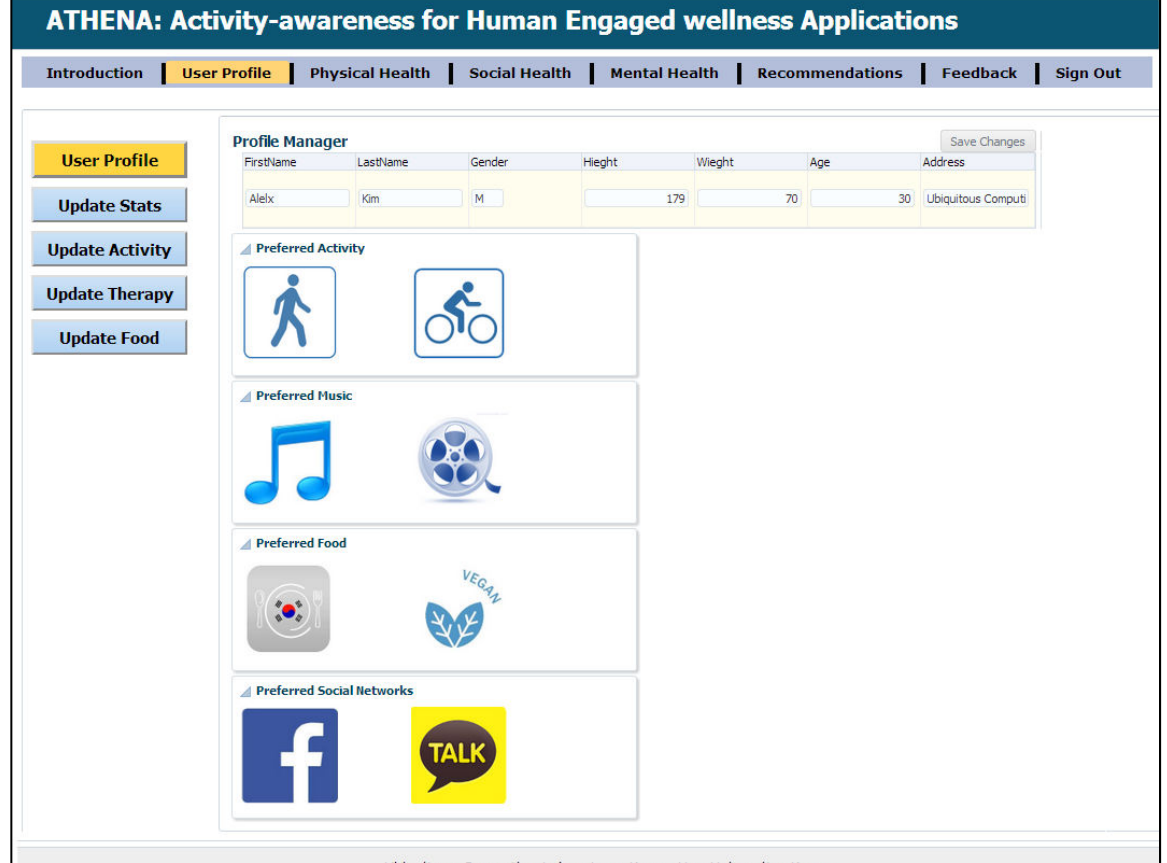
Figure 5. Personal profile